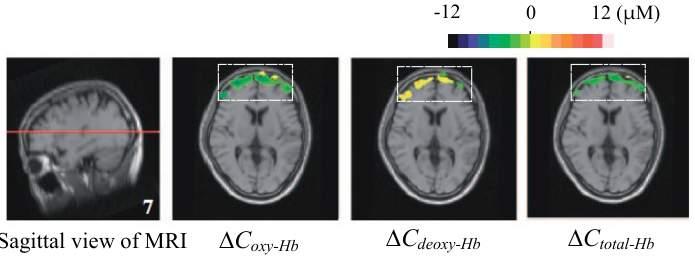
Figure 17. Hemodynamic changes in the prefrontal cortex observed by TD-DOT images during a video game task. Modified from Reference [50]. Copyright (c) 2005 The Japan Society of Applied Physics.